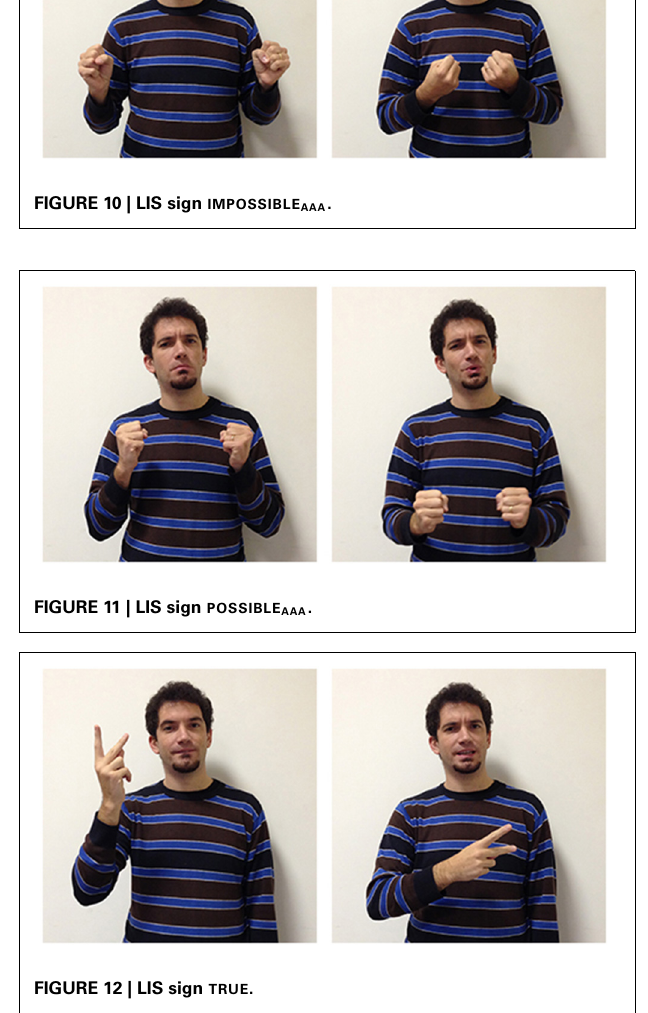
FIGURE 12 | LIS sign TRUE